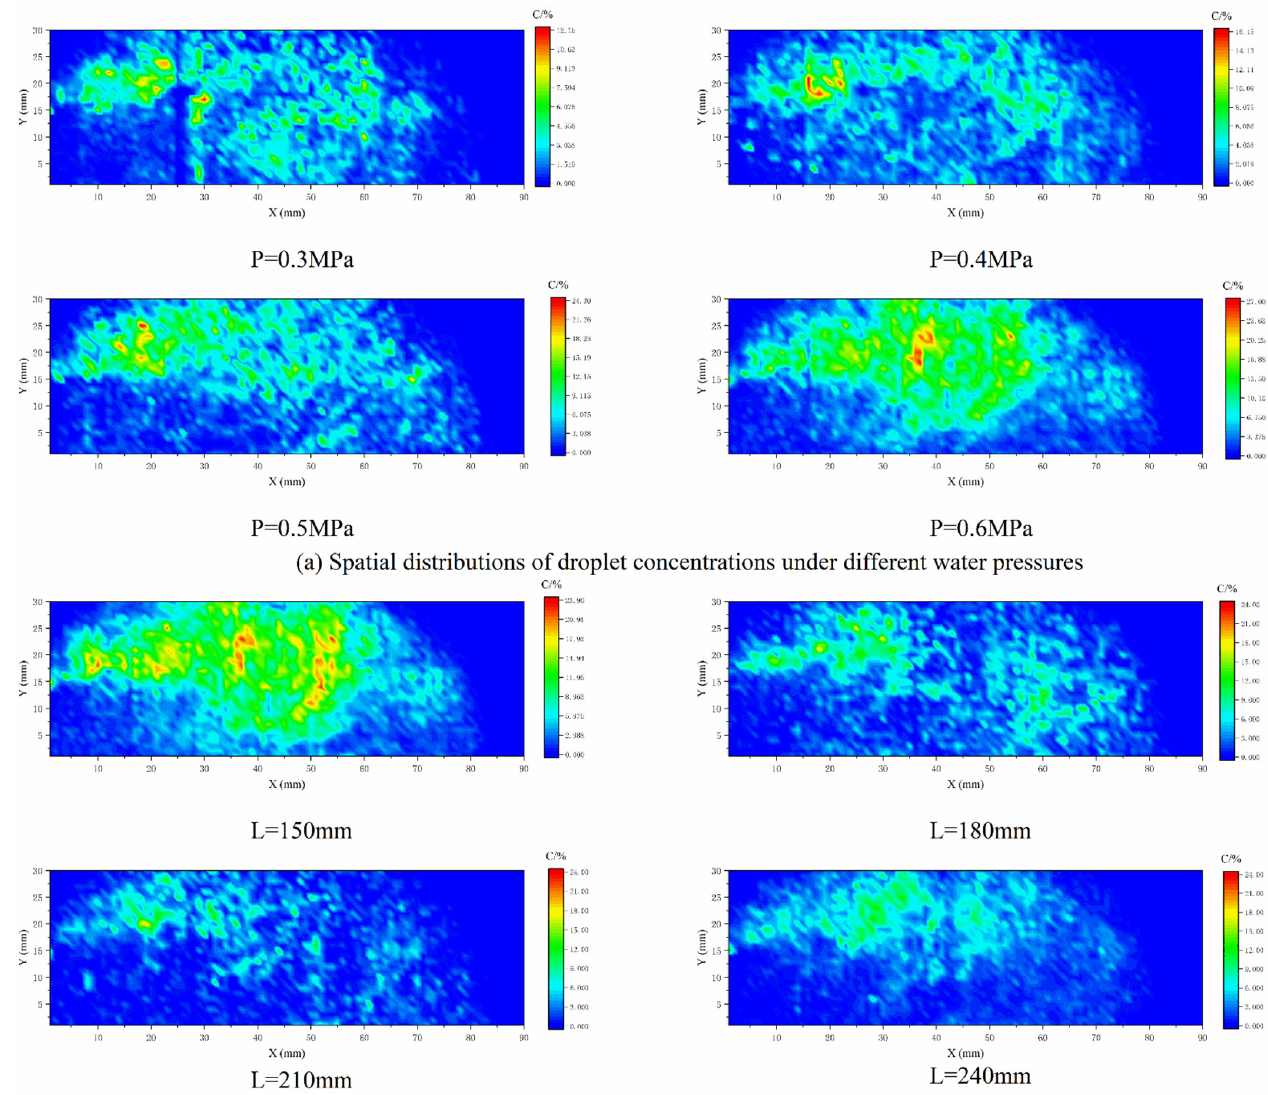
Figure 14. Spatial distributions of droplet concentration. The droplet concentration distributions along the flow and radial directions under different water pressures are depicted in Figures 15a,b. The figures reveal that the drop- lets’ spatial distribution gradually increased with an increase in water pressure difference. With the increased water pressure, the mass of liquid that was ejected simultaneously increased, thus the relative concentration value in the flow and the radial directions also increased. In the flow direction, the relative concentration of droplets increased first, and then decreased with an increase in the flow distance. The reason for this is because after the liquid collided with the front end of the stabilizer, part of the liquid diffused backward along the stabilizer wall. The droplet distribution was relatively concentrated upon leav- ing the tail edge of the stabilizer. As the droplet moved backward, the distribution range of some droplets in the back region of the recirculation zone became the widest, present- ing a peak on the flow direction concentration distribution map. Then, when reducing the camera range, the liquid droplets exceeded the view range, and gradually decreased in the flow direction concentration map. With an increase in the radial distance, the concen- tration distribution presented two peaks in the radial direction. The reason for this is